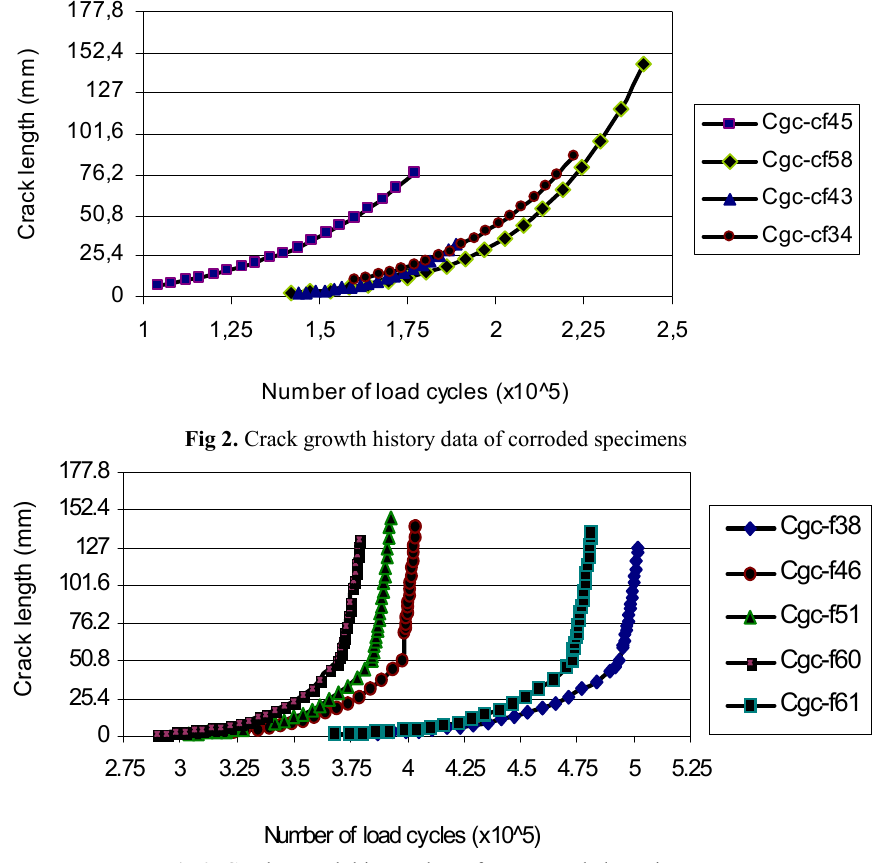
Fig 3. Crack growth history data of non-corroded specimens